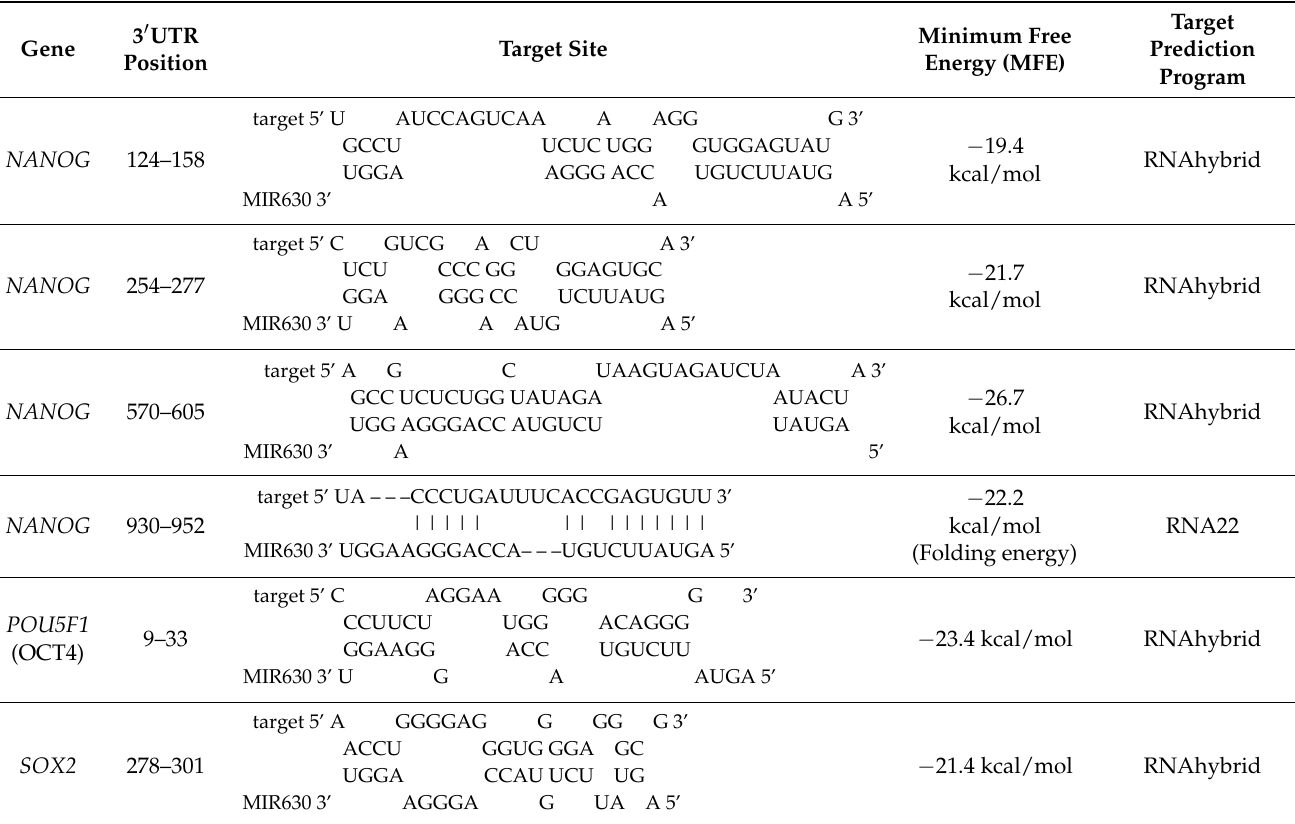
Table 2. The predicted microRNA 630 target sites in the 3 ′ UTRs of NANOG, POU5F1 (encoding for OCT4), and SOX2 . 3 ′ Gene